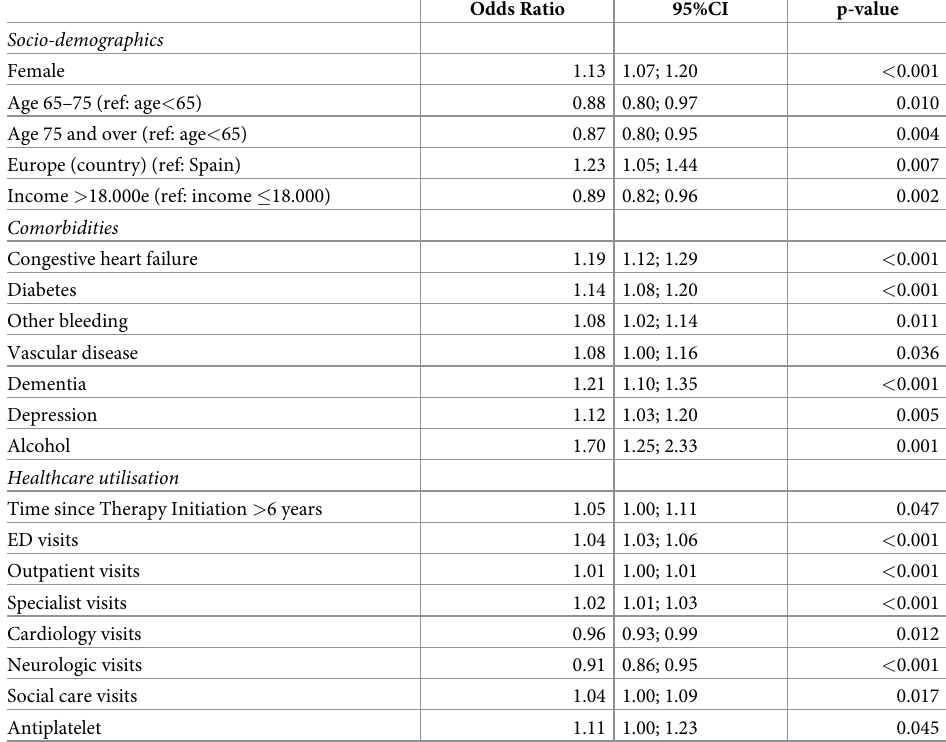
Table 3. Factors associated with poor INR